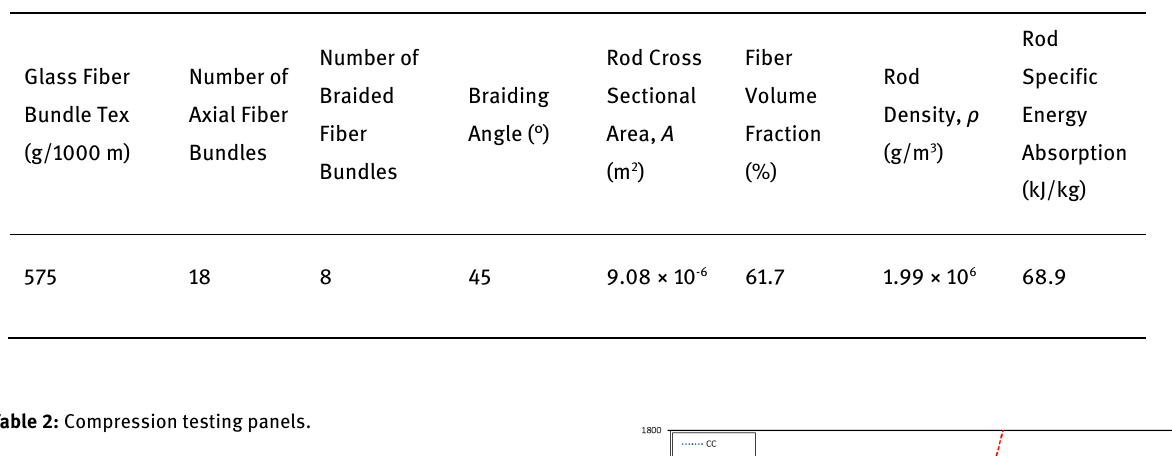
Table 1: Braided glass fiber rod material specifications [25].